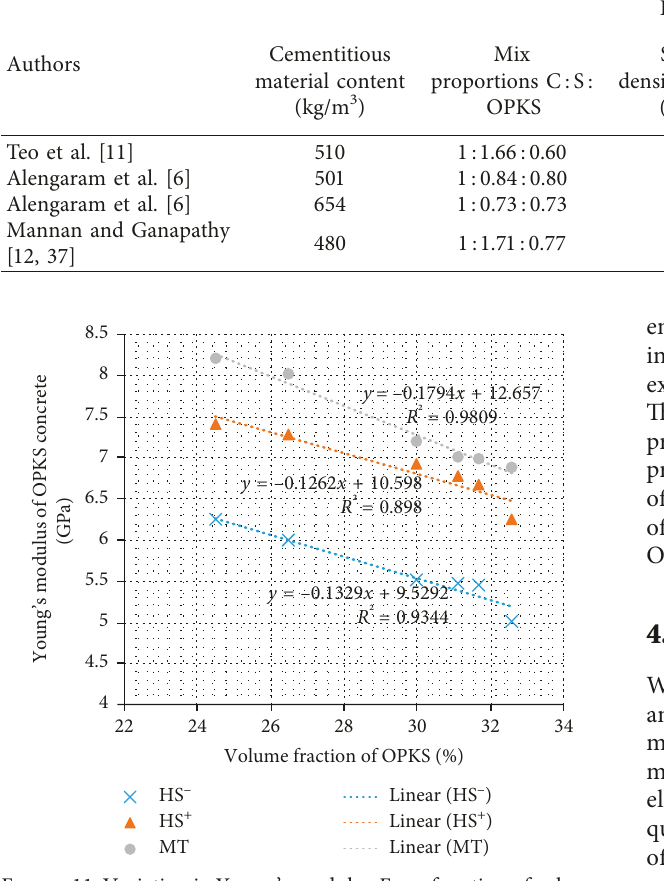
Figure 11: Variation in Young’s modulus E as a function of volume of OPKS in fraction v c